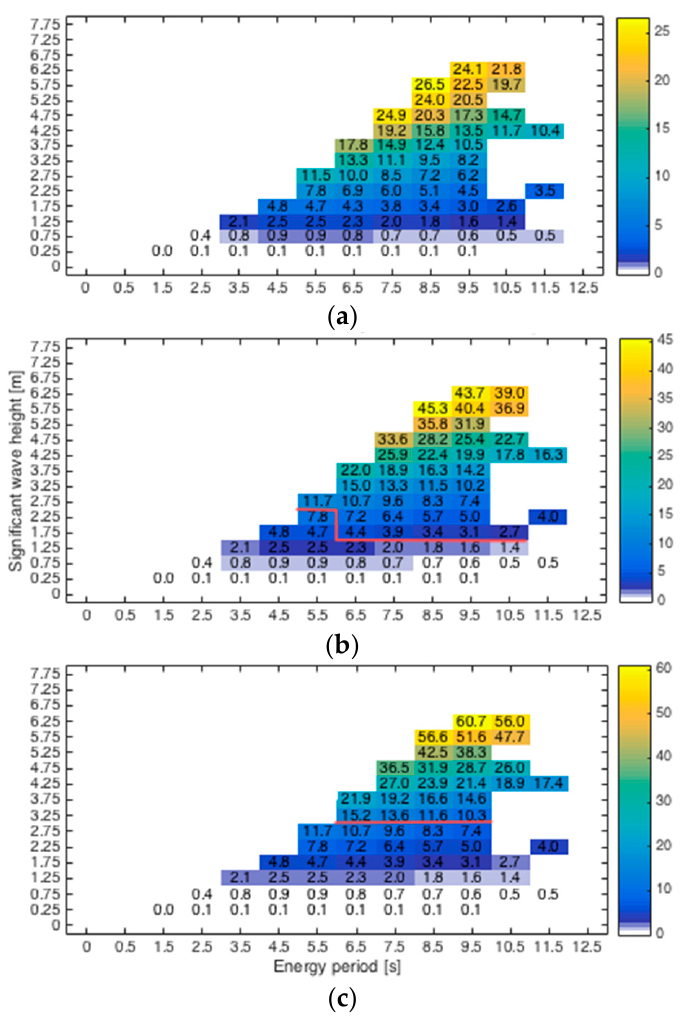
Figure 6. Power matrices for three different stroke ‐ lengths: ( a ) 2 ‐ m stroke length; ( b ) 4 ‐ m stroke length; and ( c ) infinite stroke length. The power matrices are obtained with a constant damping coefficient of 60 kN ∙ s/m and a translator mass of 10 tons. The red line marks the difference to the preceding power matrix.